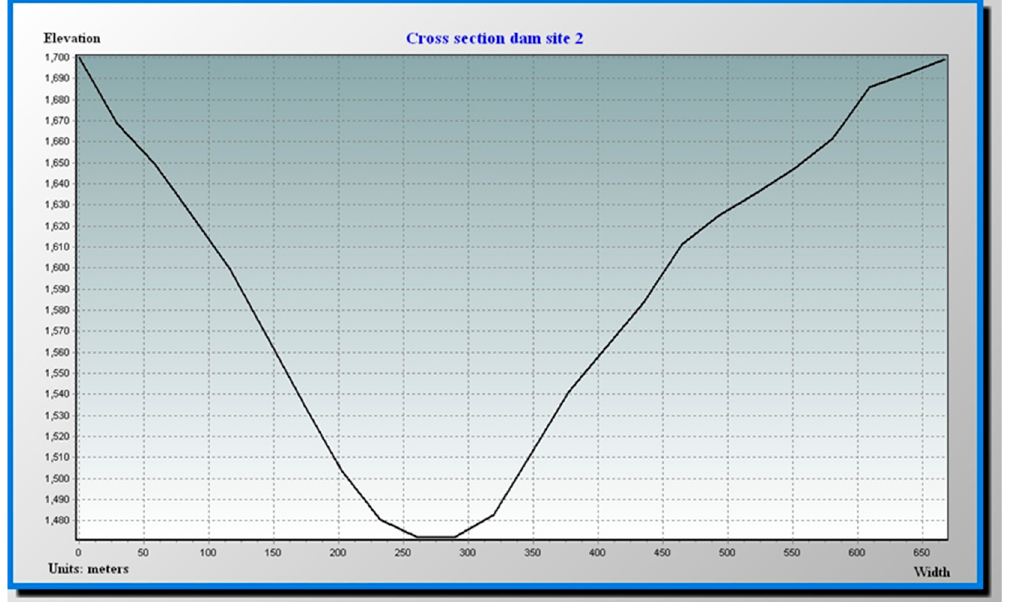
Figure 15. Cross-section area of Dam site 2.